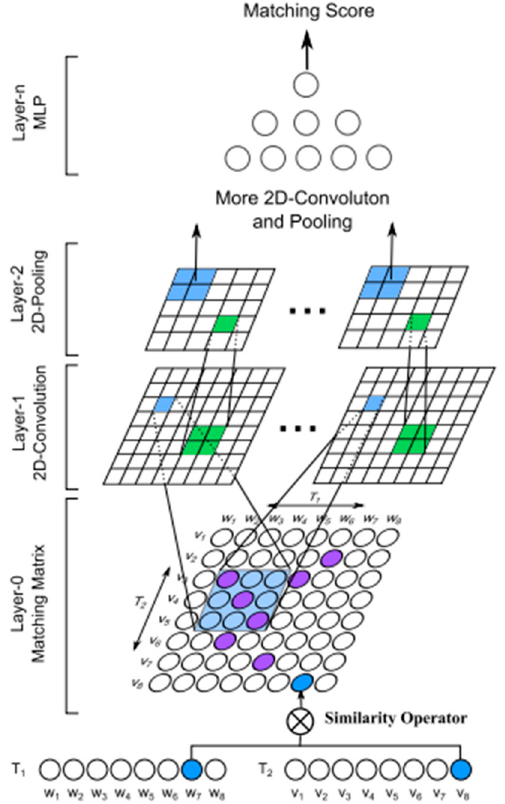
Figure 7. An overview of MatchPyramid on text matching [52].